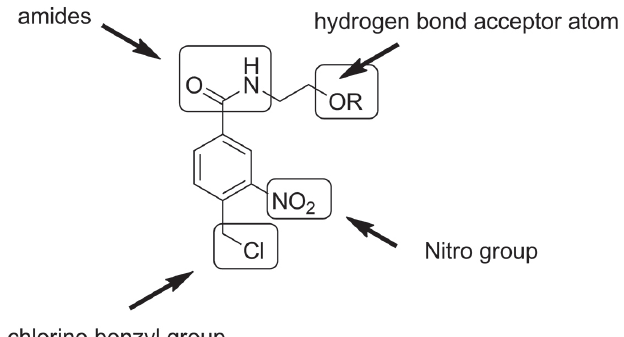
FIGURE 6 – Key functional groups important for anti- schistosomal